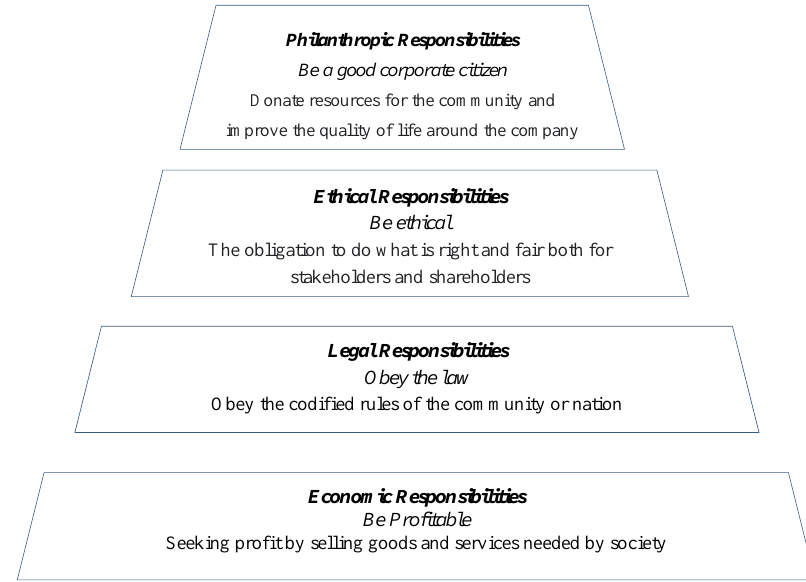
Figure 1: The Pyramid of Corporate Social Responsibility; Source: Carroll